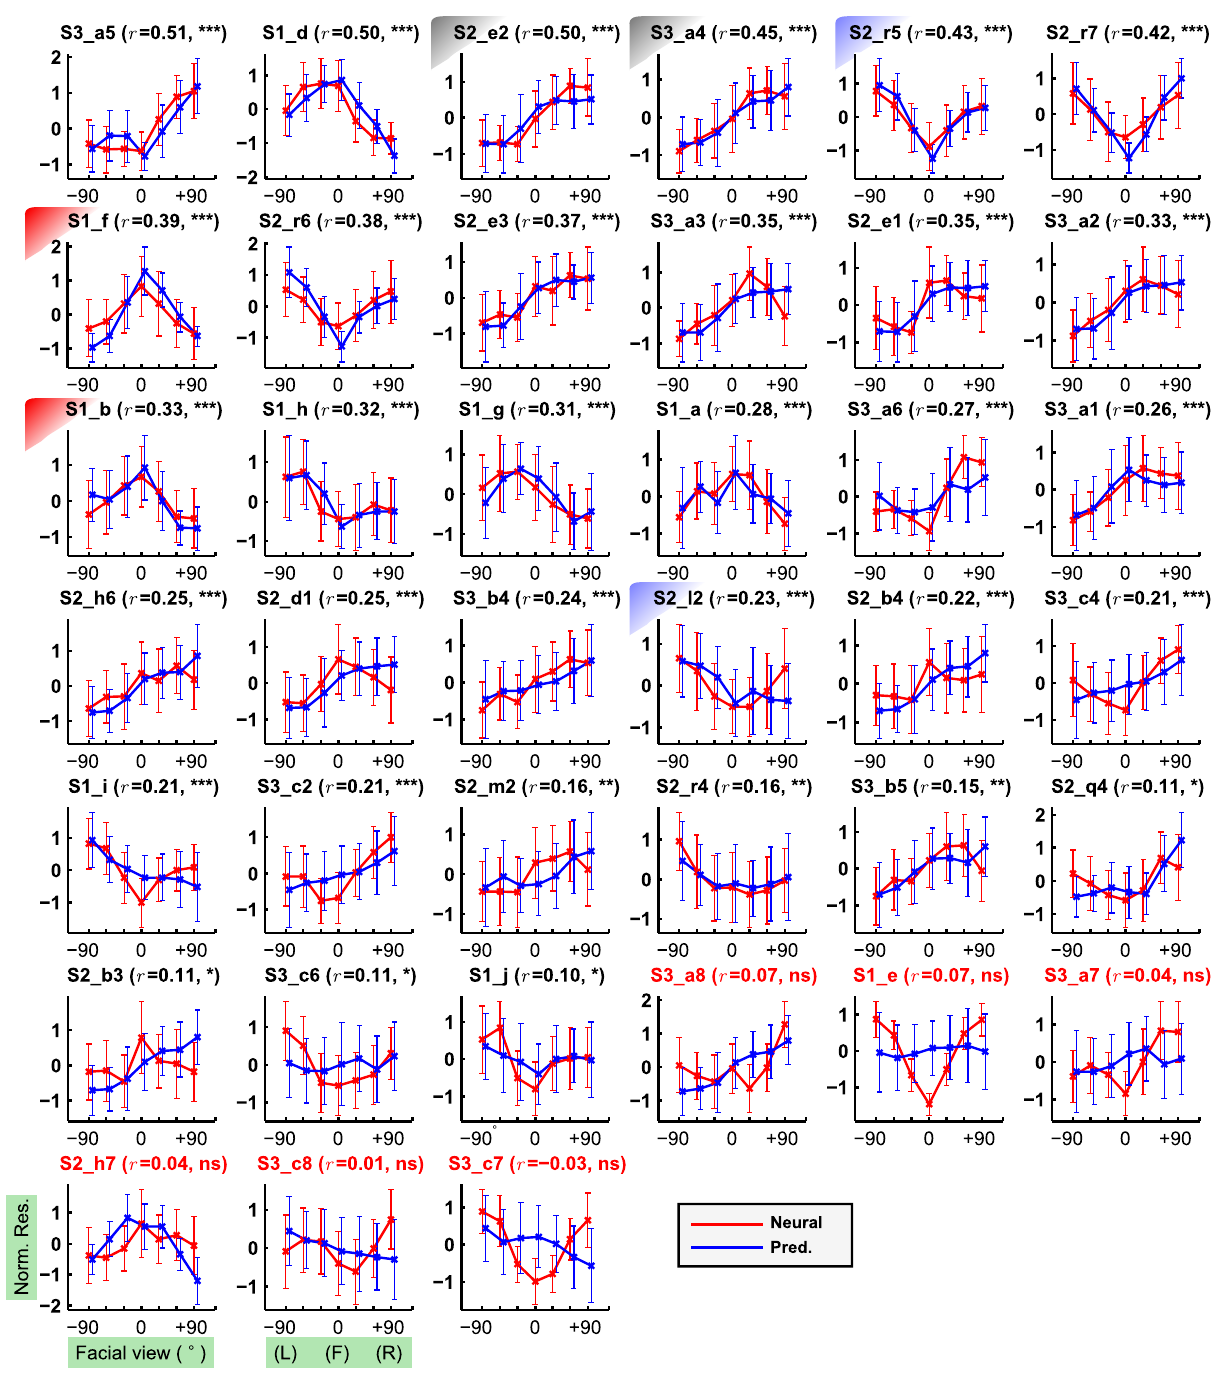
Figure 2. Actual and predicted view tuning curves from 39 recording sites. Mean and standard deviation across identities are plotted after taking a z-score (see “Methods”). The sites are sorted by the predictability ( r ), estimating the correlation between two view tuning curves. The site ID is labeled above each panel. Among 39 sites, significant correlation (p < 0.05) was found from 33 sites (= 84.6%, the site IDs are in black). * p < 0.05, ** p < 0.01, and *** p <